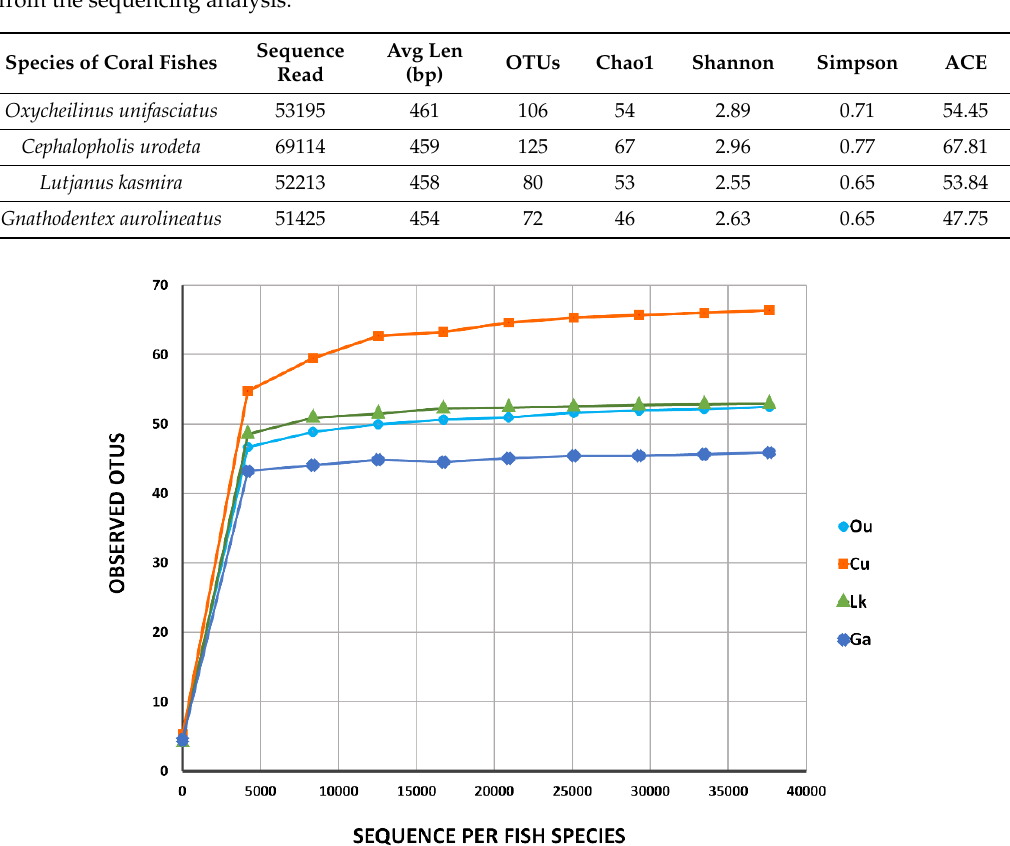
Figure 2. Rarefaction curves of four coral reef fishes from the South China Sea. Ou: O. unifasciatus , Cu: C. urodeta , Lk: L. kasmira , Ga: G. aurolineatus.